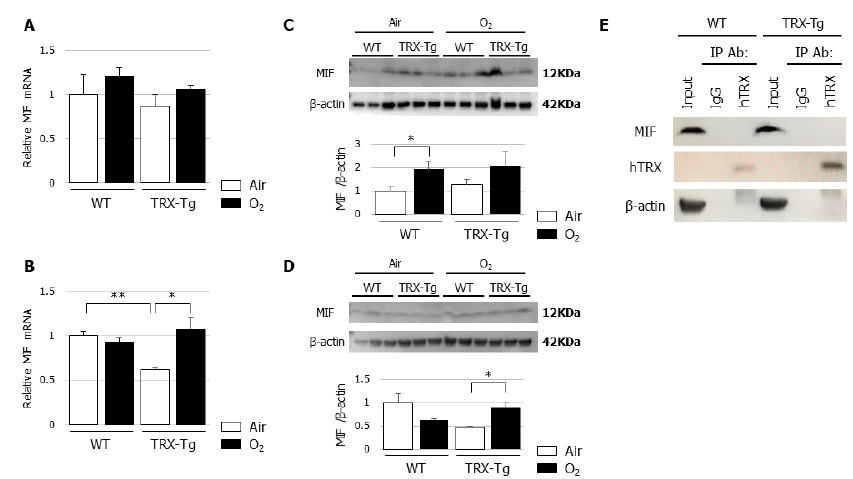
Figure 6. ( A , B ) Mif mRNA expression levels. Quantitative RT-PCR for MIF was performed on ( A ) day 4 and ( B ) day 14 ( n = 6 per group). ( C , D ) MIF protein expression levels. Western blot analysis for MIF was performed on ( C ) day 4 and ( D ) day 14. Animals were exposed to air (open bars) or O 2 (filled bars). Data are shown as means ± SEM. Comparisons between groups were performed using one-way ANOVA followed by Tukey’s test. * p < 0.05. Air: Normoxia; O 2 : Hyperoxia; MIF: Macrophage migration inhibitory factor; WT: Wildtype; TRX: Thioredoxin-1; Tg: Transgenic; SEM: Standard error of the mean; ANOVA: Analysis of variance. ( E ) Immunoprecipitation of TRX with MIF. Immunoprecipitation using normal IgG and anti-TRX antibody was analyzed by Western blot analysis. The antibodies for Western blotting were anti-MIF, anti-hTRX, and anti- β -actin. hTRX: Human thioredoxin; MIF: Macrophage migration inhibitory factor.